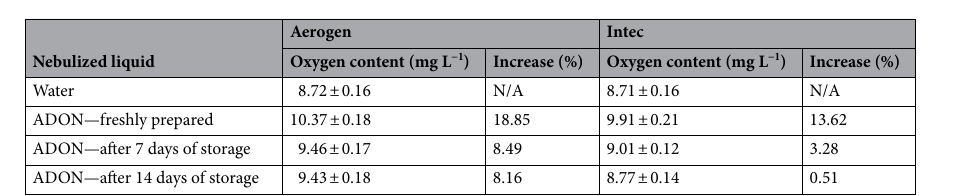
Table 4. Comparison of oxygen content in the mists measured directly at the outlet of VMNs for water and ADON. Values are means ± SD, n = 3.